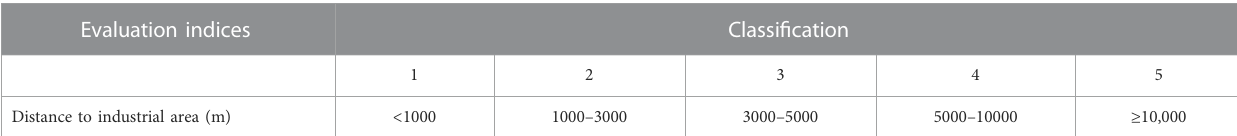
TABLE 4 Distance classi fi cation to industrial area.